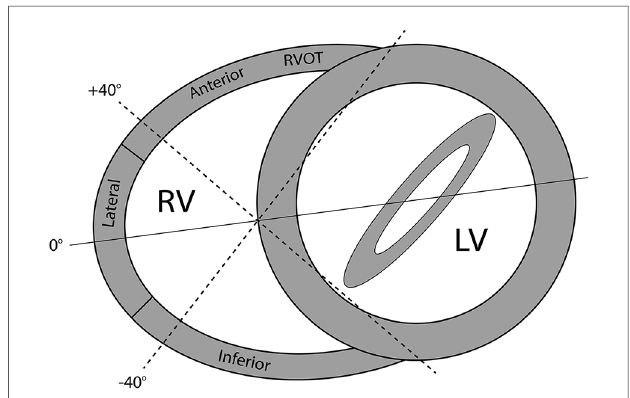
FIGURE 1 Multi-plane imaging of the right ventricle (RV) using 2D multi-plane echocardiography. Views obtained by electronic plane rotation around a single RV focused apical echocardiographic position. 0° rotation: lateral wall; +40°: anterior wall; − 40°: inferior wall.